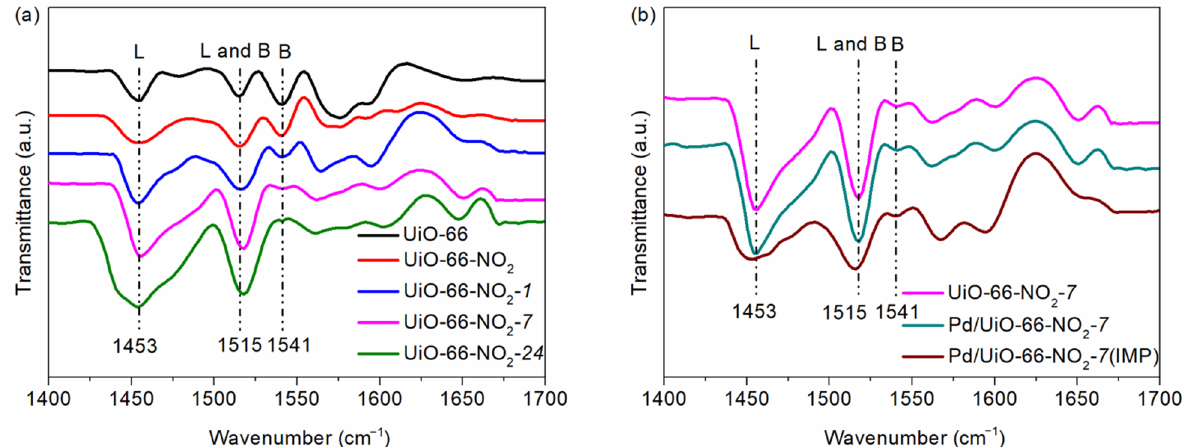
Figure 4. FT − IR spectra of adsorbed pyridine on ( a ) UiO-66 and UiO-66-NO 2 - t ; ( b ) UiO-66-NO 2 - 7 , Pd/UiO-66-NO 2 - 7 , and Pd/UiO-66-NO 2 - 7 (IMP).